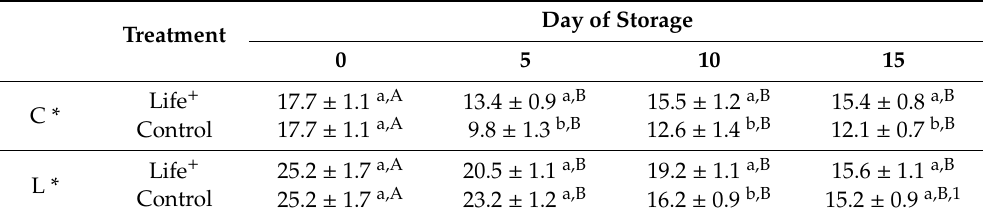
Table 3. Color parameters of sweet cherries stored at 6 ◦ C for 15 days.